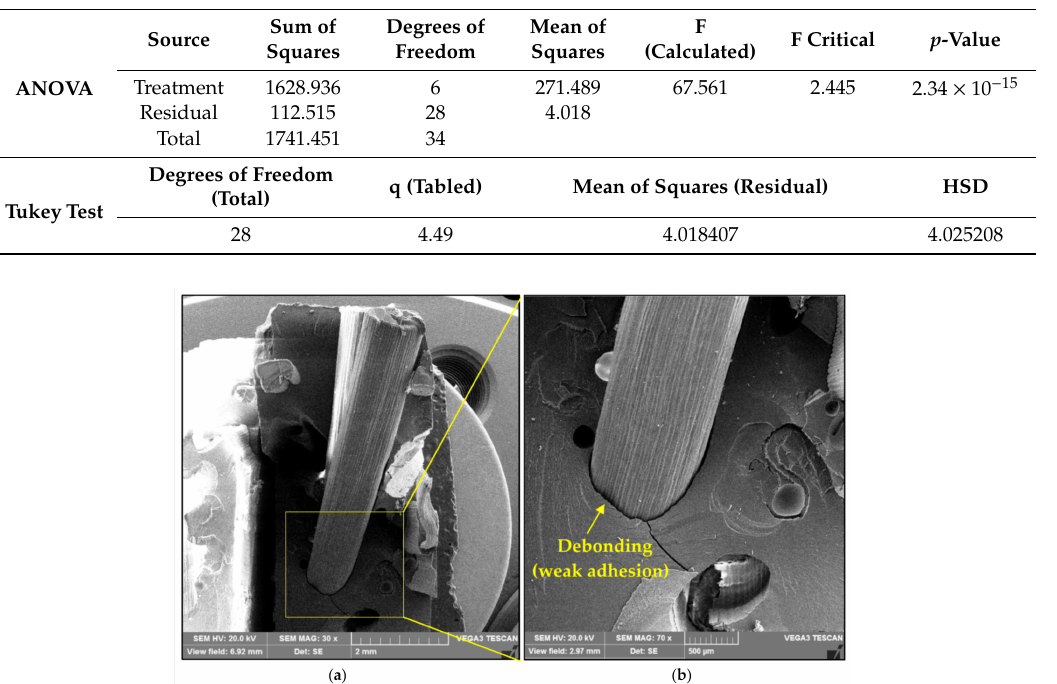
Figure 10. SEM images of fracture surfaces of composites with untreated ra ffi a fibers: ( a ) with a length of 15 mm, and ( b ) detail of the fiber debonding.